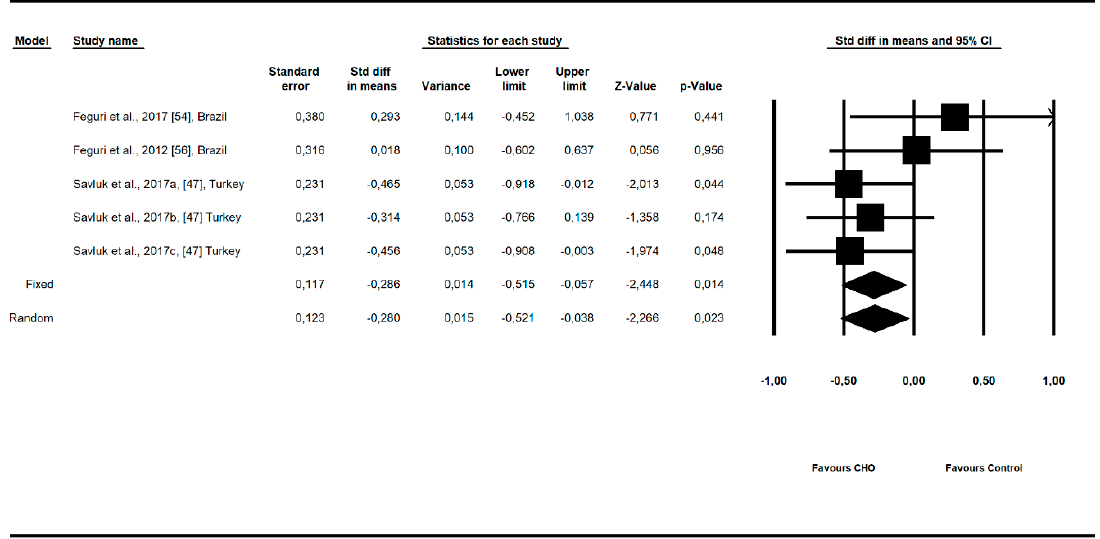
Figure 2. An e ff ect size standardized mean di ff erence, for aortic clamping (AC) duration (minutes) in Figure 2. An effect size standardized mean difference, for aortic clamping (AC) duration (minutes) in patients taking oral carbohydrates (OCH) drinks vs. controls. Std di ff in means—standardized mean patients taking oral carbohydrates (OCH) drinks vs. controls. Std diff in means ‐ standardized mean di ff erence; 95%Cl—95% confidence interval. difference; 95%Cl – 95% confidence interval.